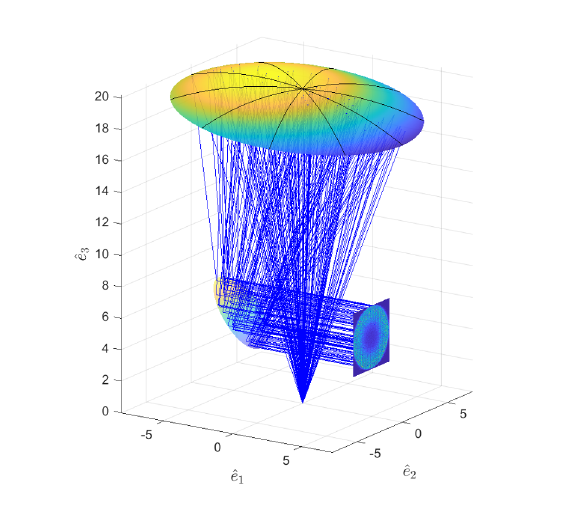
Figure 3: The layout of our test case using a laser diode and an annular output.